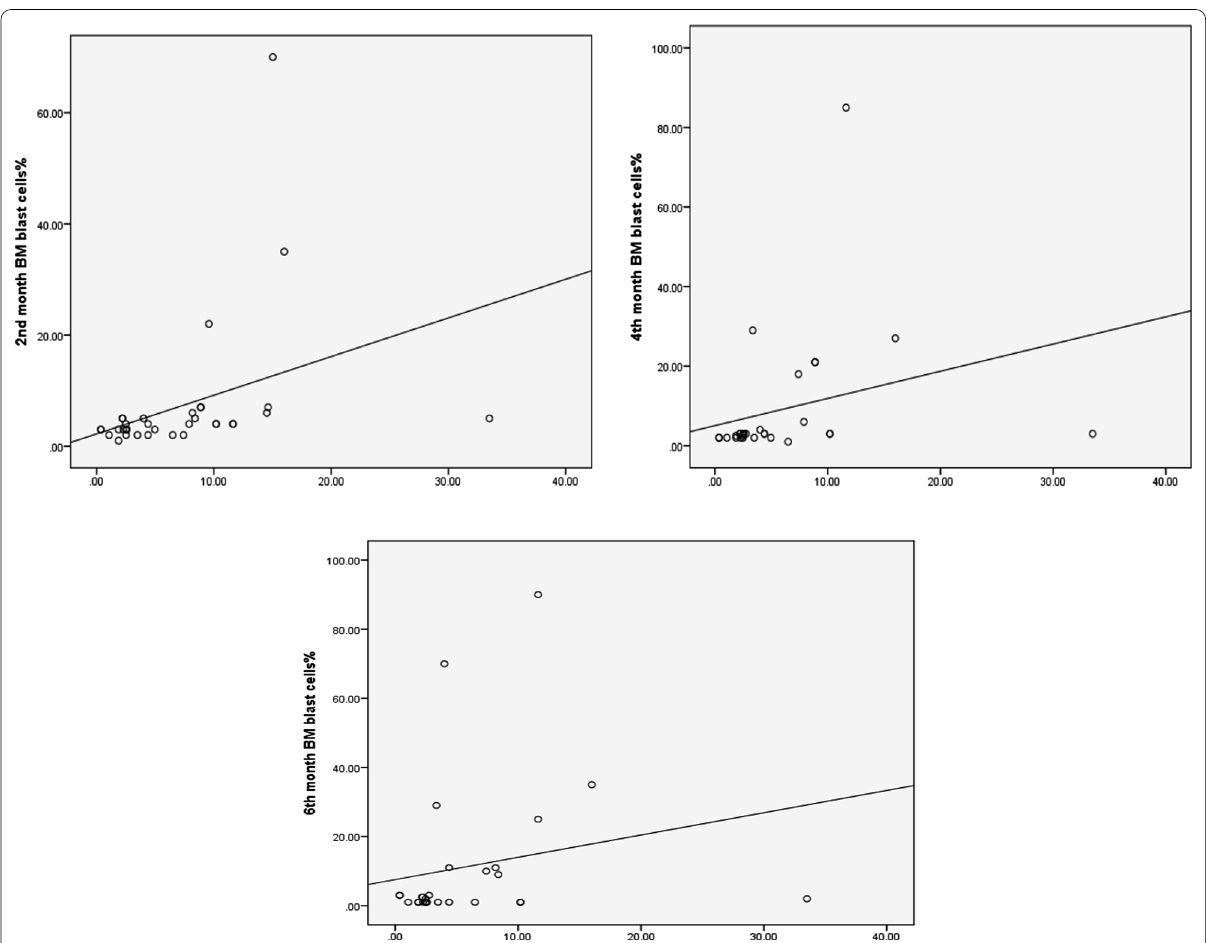
Fig. 5 Scatter plot between METTL3 gene expression level during follow‑up and 2nd, 4th and 6 th month BM blast counts